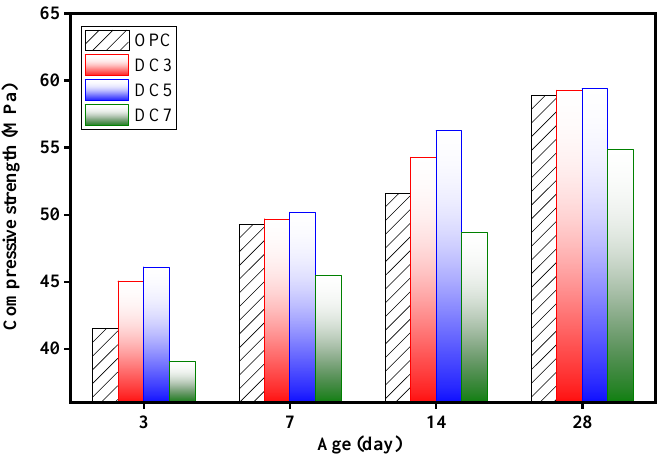
Figure 10. Compressive strengths of samples. Table 4. Compressive strength values and rates of variation in compressive strength of the con- cretes.